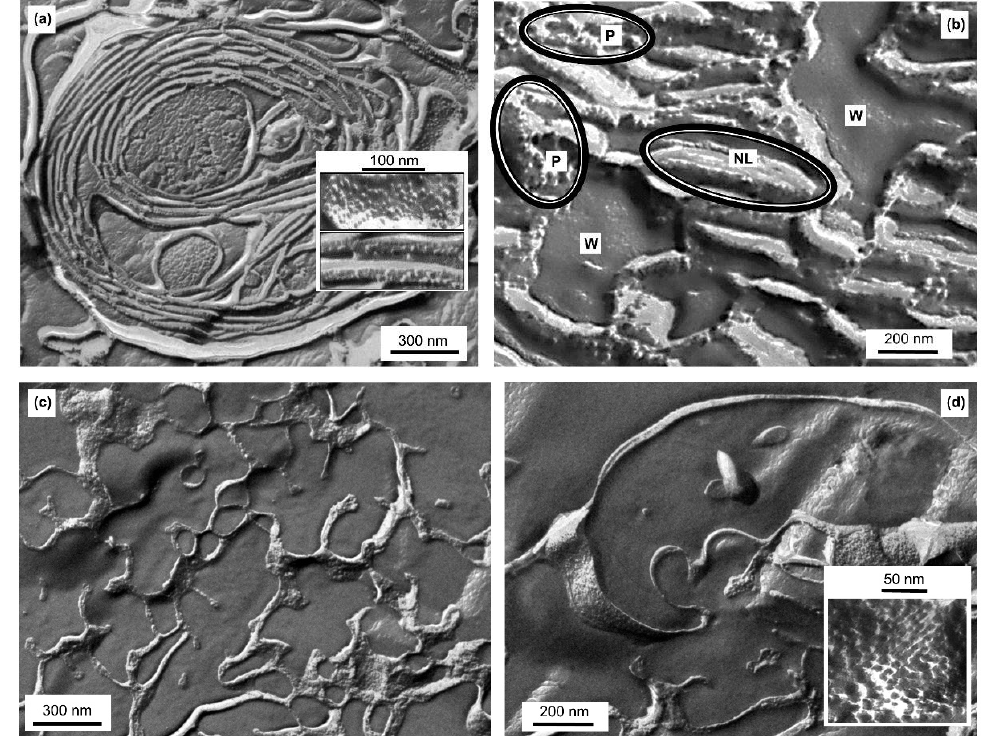
Figure 5. Freeze-fracture electron microscopy images of granum ( a , b ) and stroma ( c , d ) TMs; images of different regions with different magnifications; insets in ( a , d ), protein rich regions; P, W, and NL in ( b ) stand for regions dominated by proteins, water and non-bilayer lipid phase.